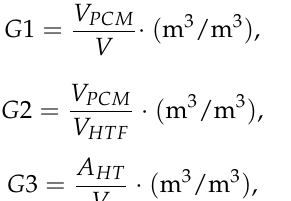
Figure 11. The prototype inserts tested in the shell and tube ( a ) and fin tubes ( b ) versions of the LHTES. For comparison, it was assumed that the tank has a cylindrical shape with a diameter of 900 mm and a height of 1800 mm. The influence of edge effects was not considered in the comparison. In all LHTES geometries, due to low typically thermal conductivity of the phase change materials, the key parameter is the ratio of heat transfer area to the PCM volume. The second, but no less important, parameter is the ratio of the PCM volume to the total volume of the vessel. The following three coefficients, based on geometrical parameters, were introduced to evaluate individual constructions of LHTES.